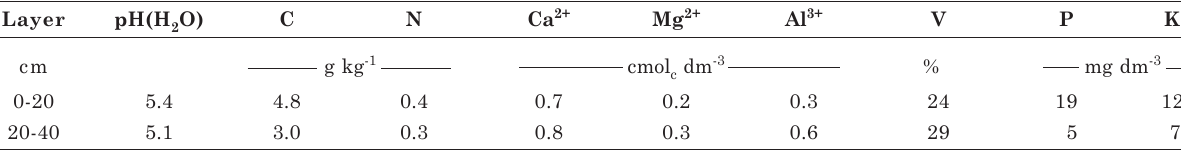
Table 1. Soil chemical properties in the experimental